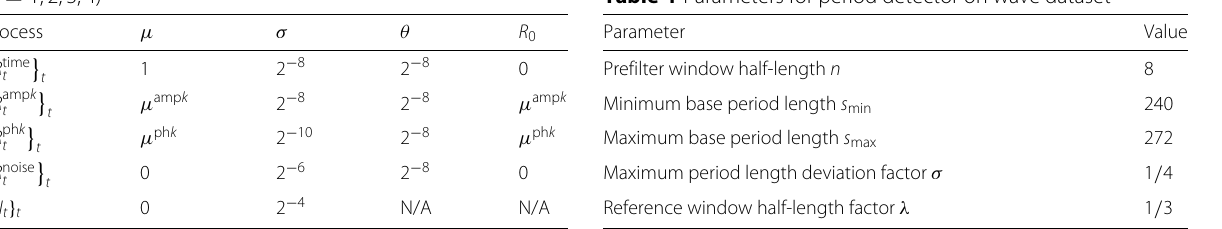
Table 3 Parameters for processes governing generated